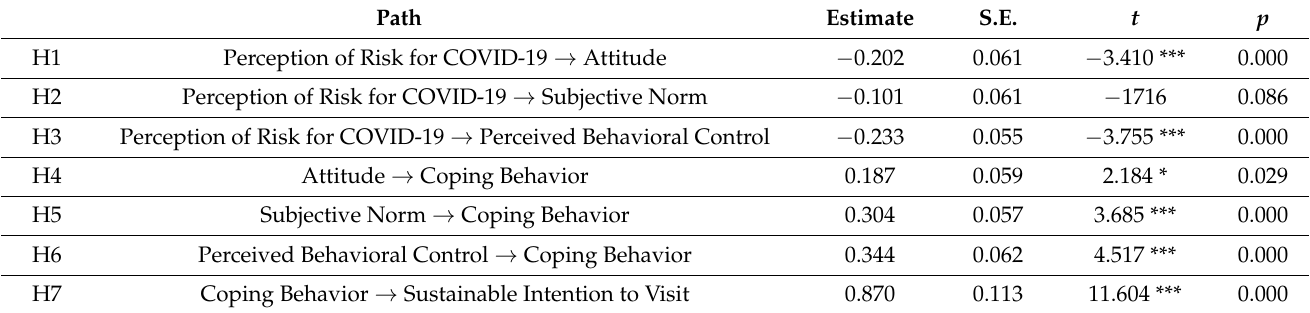
Table 4. Results of testing hypotheses by means of